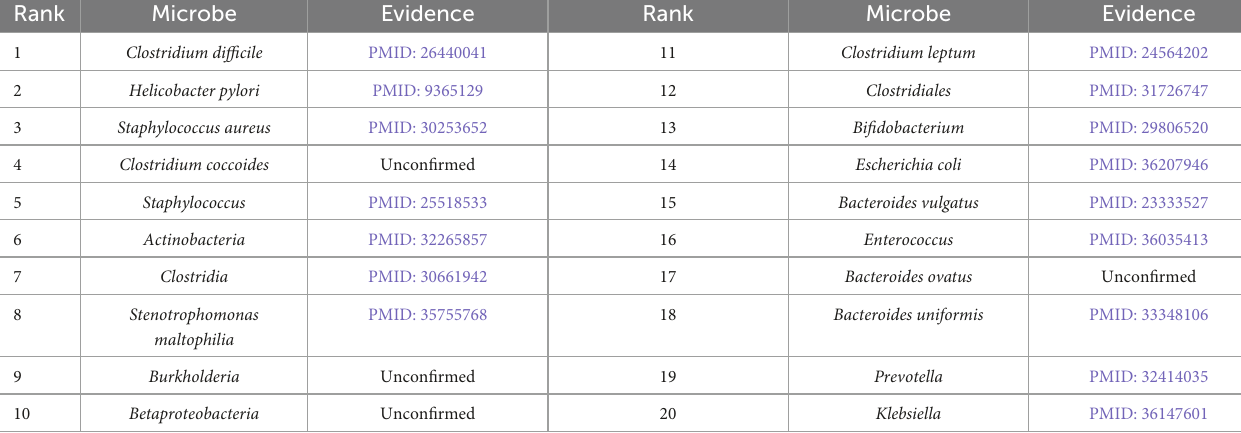
TABLE 5 Prediction results of top-20 liver cirrhosis-related microbes.